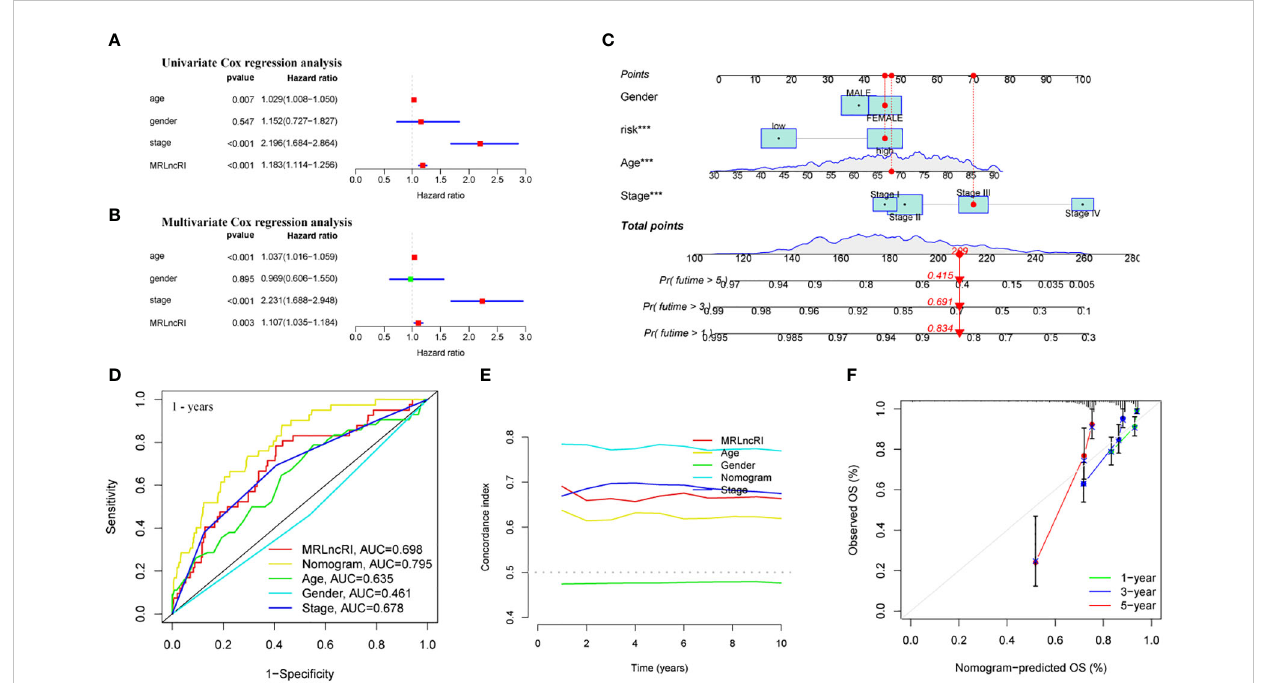
FIGURE 6 Construction and evaluation of nomogram. (A) Univariate Cox regression analysis of MRLncRI and common clinical parameters in CRC. (B) Multivariate Cox regression analysis of MRLncRI and common clinical parameters in CRC. (C) Nomogram combined with MRLncRI and common clinical parameters. (D) ROC of nomogram, MRLncRI and common clinical parameters. (E) C-index of nomogram, MRLncRI and common clinical parameters. (F) Calibration curves of nomogram predicting 1-year, 3-year and 5-year OS in CRC